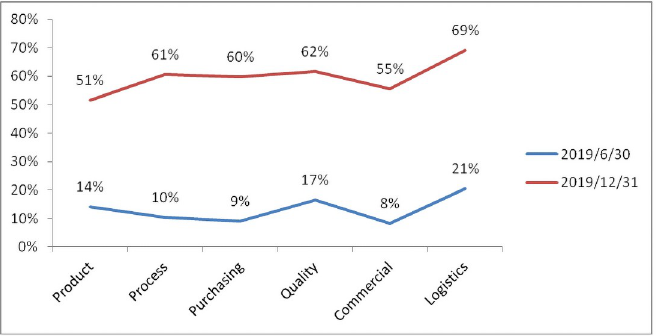
Fig 13. Task on-time completion rate (2019.6 VS